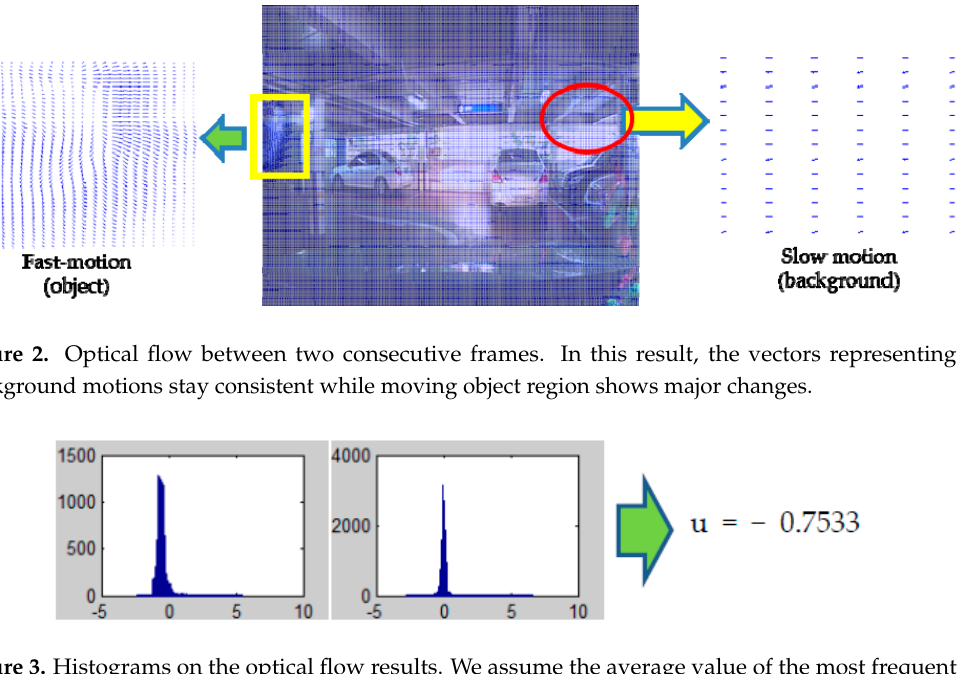
Figure 3. Histograms on the optical flow results. We assume the average value of the most frequent section found on the histogram as the ego-motion.